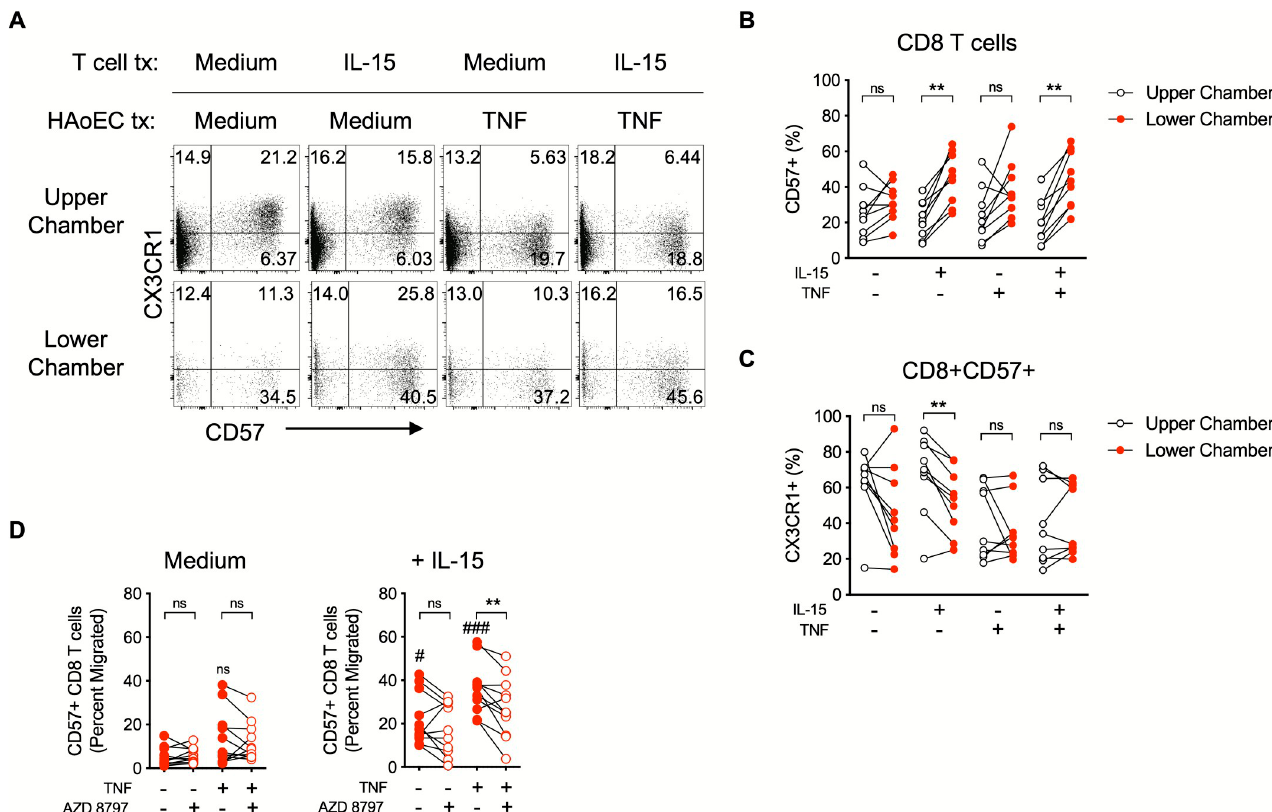
Fig 6. Chemoattraction of activated CX3CR1+ CD8 T cells to an endothelial cell monolayer. (A) Representative dotplots showing CX3CR1 and CD57 expression on CD8 T cells. (B) Percentage of CD8 T cells in each chamber expressing CD57. (C) Percentage of CD57+ CD8 T cells in each chamber expressing CX3CR1. (D) Absolute number of CD57+ CD8 T cells in the lower chamber expressed as a percent of total (upper chamber + lower chamber) CD57+ CD8 T cells (“Percent migrated”) pre-treated with medium control (left) or IL-15 (right). Actual numbers of cells recovered in the assay are depicted in S5 Fig. (B-D) Differences between groups were determined by Wilcoxon rank sum test: � P � 0.05; ns, not significant. HAoECs, human aortic endothelial cells; tx, treatment.